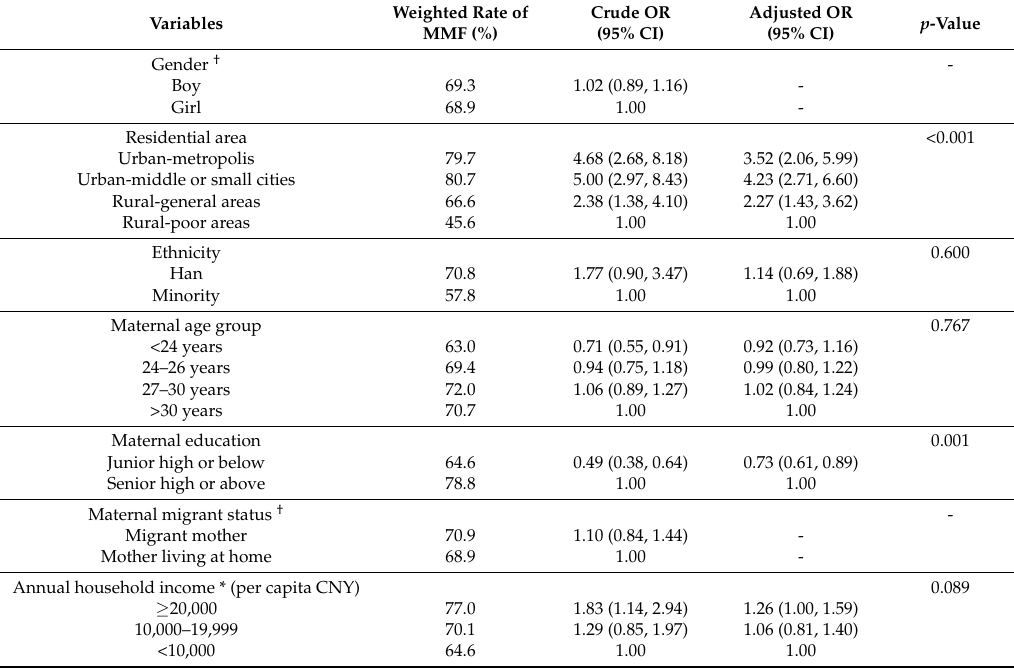
Table 4. Determinants of minimum meal frequency (MMF) for children aged 6–23 months.